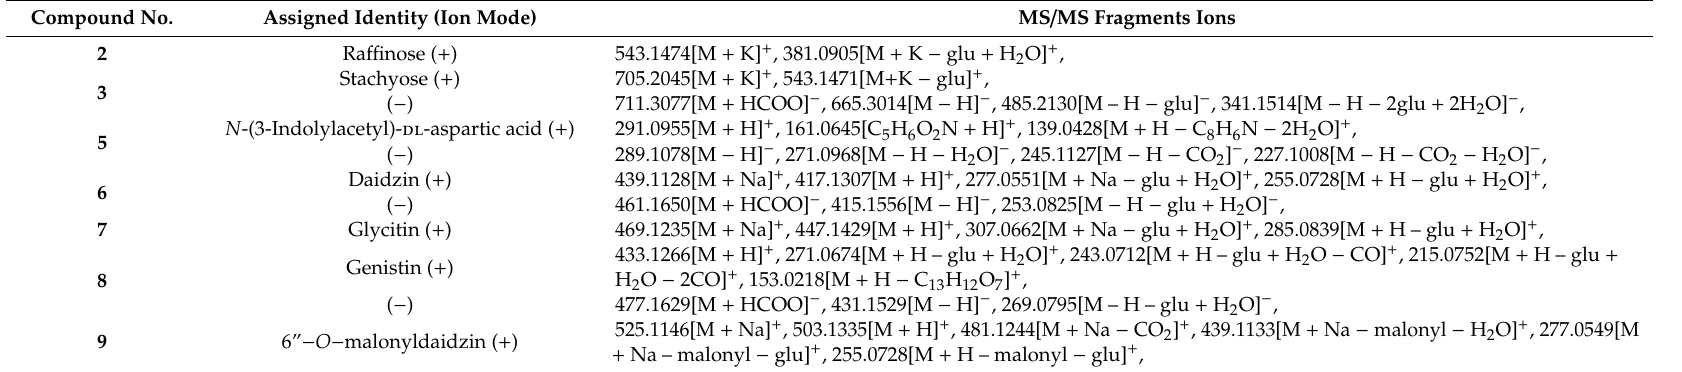
Table 2. Mass spectral interpretation of assigned compounds in soybean and Sojae semen praeparatum products. Compound